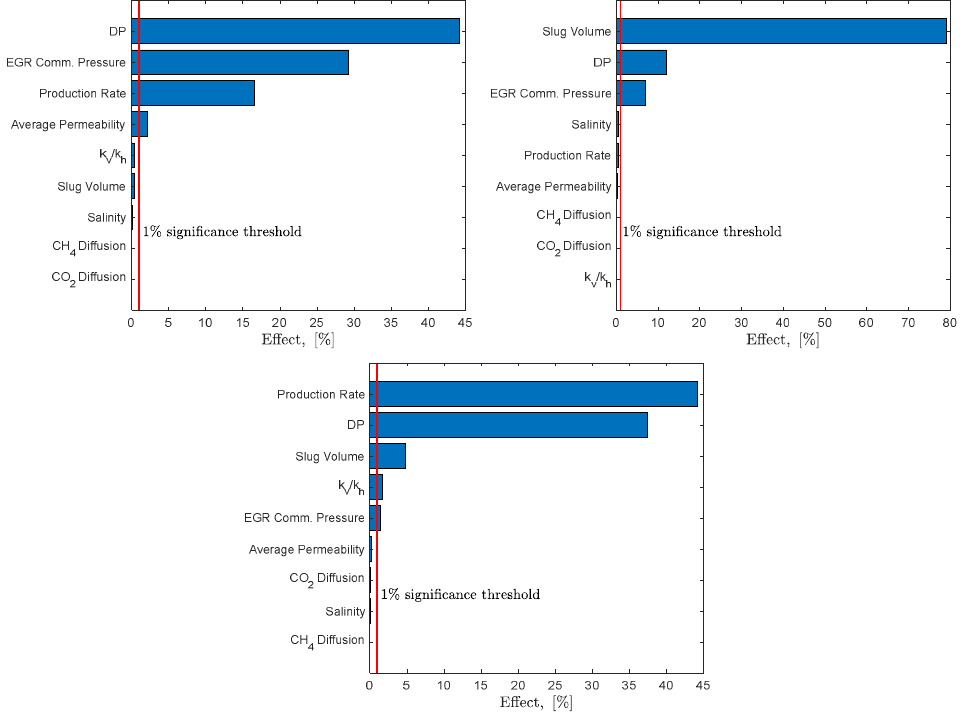
Figure 13. Sobol sensitivity of the influence of 9 parameters on recovery factor (top left), CO 2 stored (top right), and CO 2 recycled (bottom).